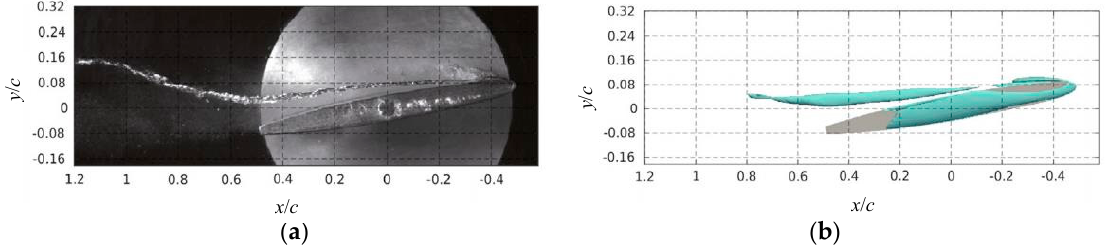
Figure 13. Comparison between numerical results and experiment results: ( a ) high-speed video images of tip-vortex trajectory; ( b ) cavitation cloud calculated using Reynolds-averaged Navier-Stokes (RANS) [29].